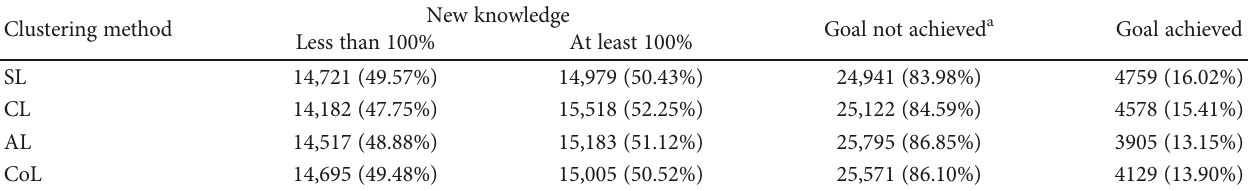
Table 5: Inference e ffi ciency vs. clustering